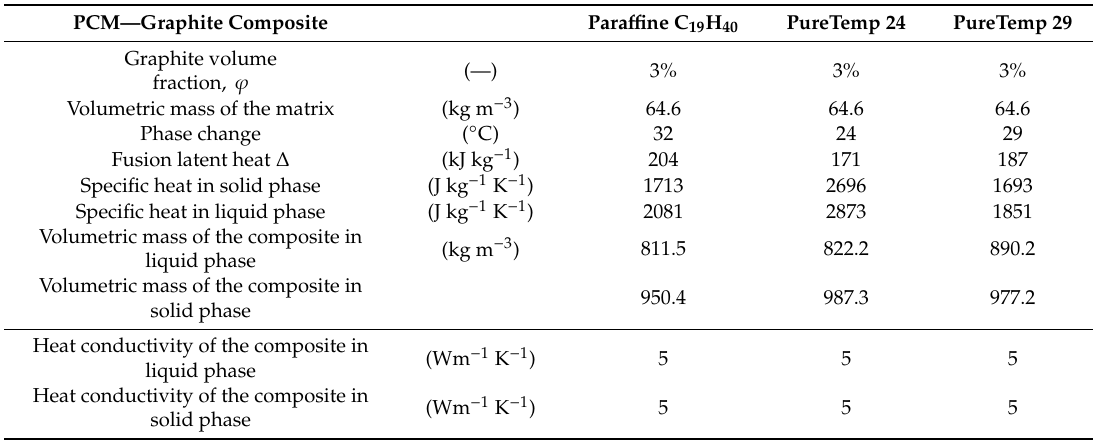
Table 1. Key physical characteristics of the three composite materials considered, computed according to the method proposed by Py et al.